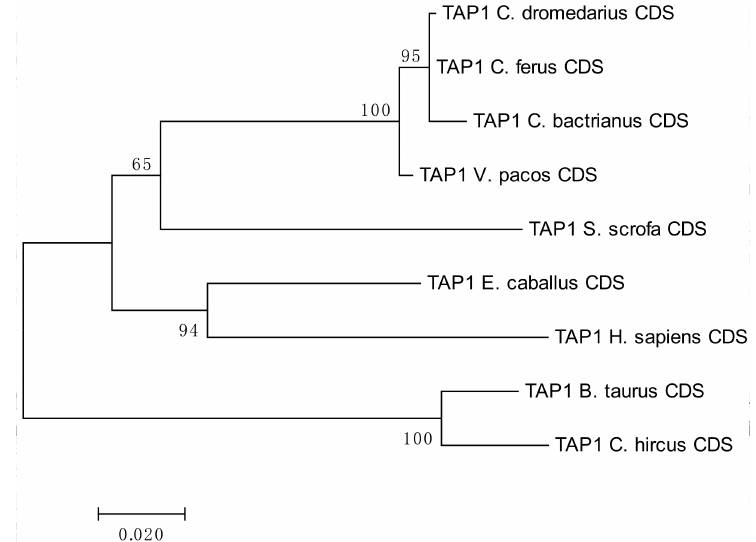
Figure 1. Phylogenetic tree of selected TAP1 coding sequences (CDSs). The tree is based on the maximum-likelihood method using Tamura 3-parameter model with gamma distribution (five categories, parameter = 0.5098). Number of bootstraps =